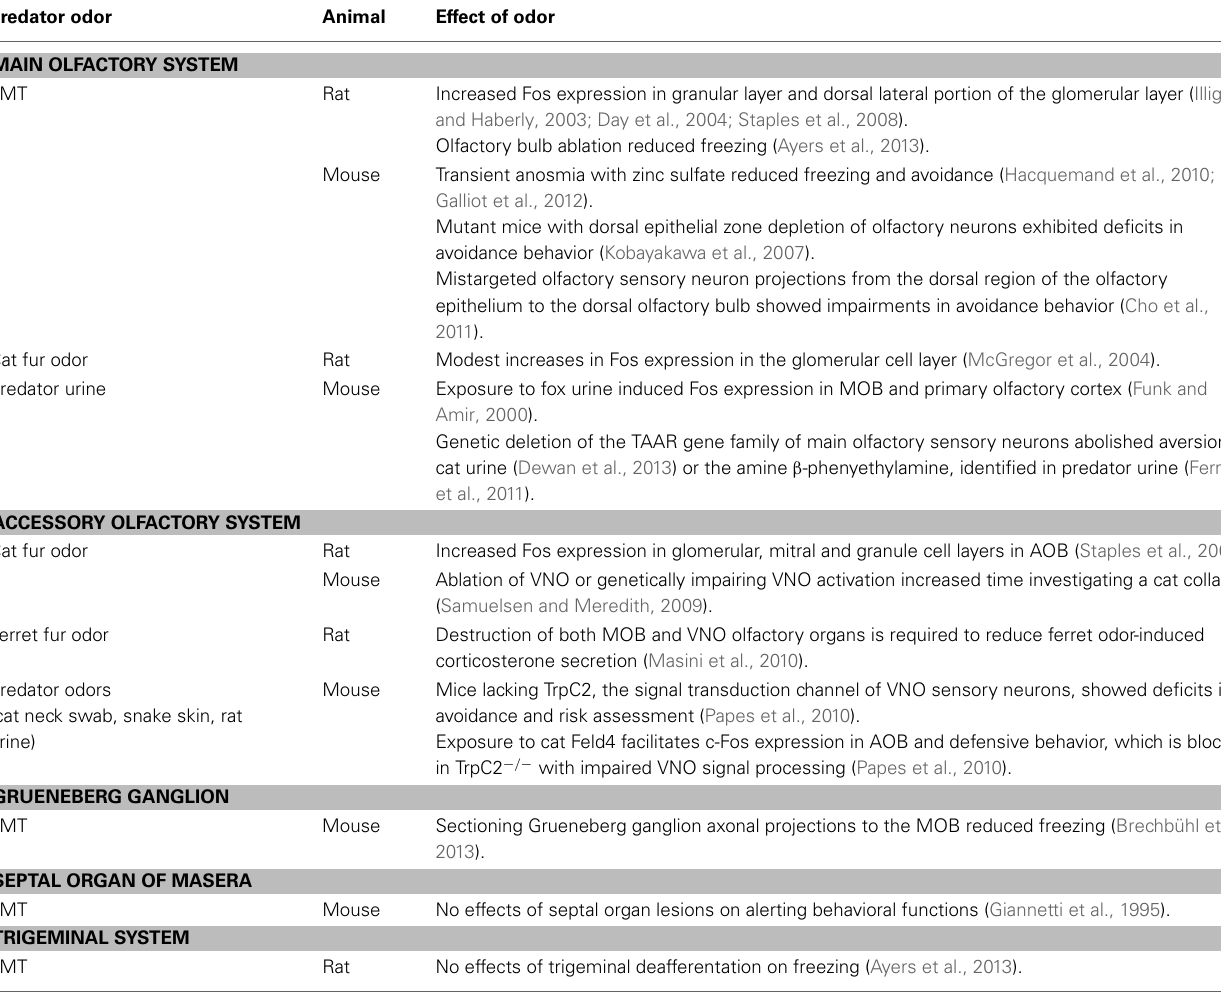
Table 1 | Roles of the olfactory systems in modulating predator odor fear. Predator odor